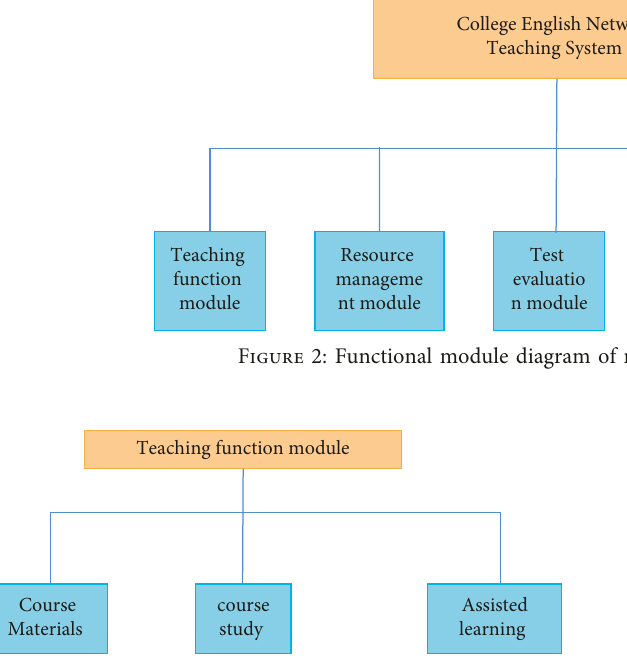
Figure 5: Schematic diagram of test and evaluation